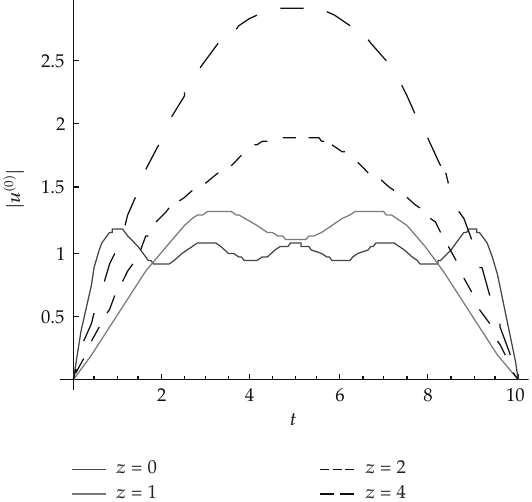
Figure 14: The zero-order approximation | u (cid:3) 0 (cid:4) | at α (cid:8) 1, T (cid:8) 10, γ (cid:8) 02 for di ff erent values of z , considering only one term in the series (cid:3) M (cid:8) 1 (cid:4) .